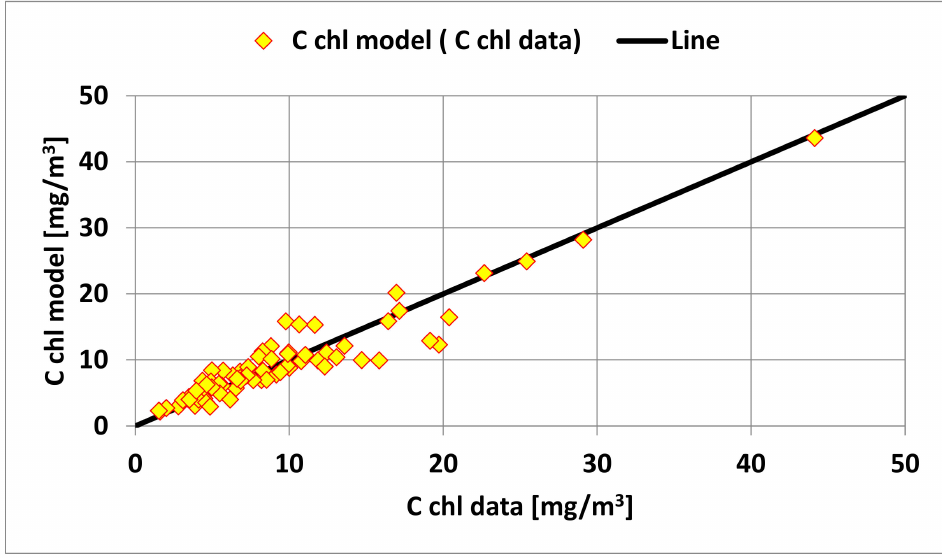
Figure 14. Model fit (C chl model) (14) to the measured concentrations of chlorophyl-a (C chl data) at the known turbidity values.